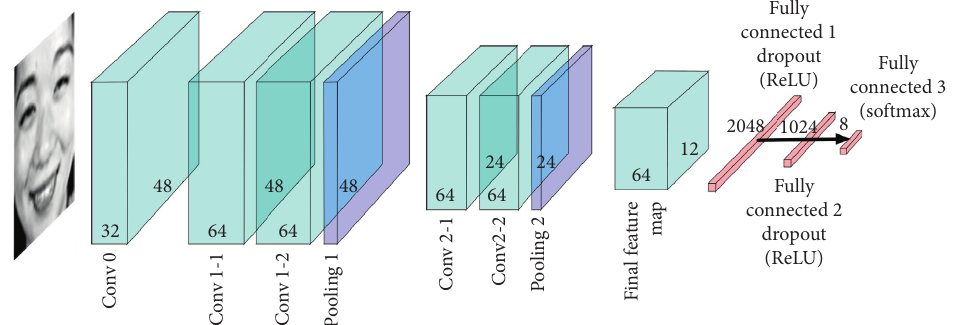
Figure 5: The structure of the applied CNN